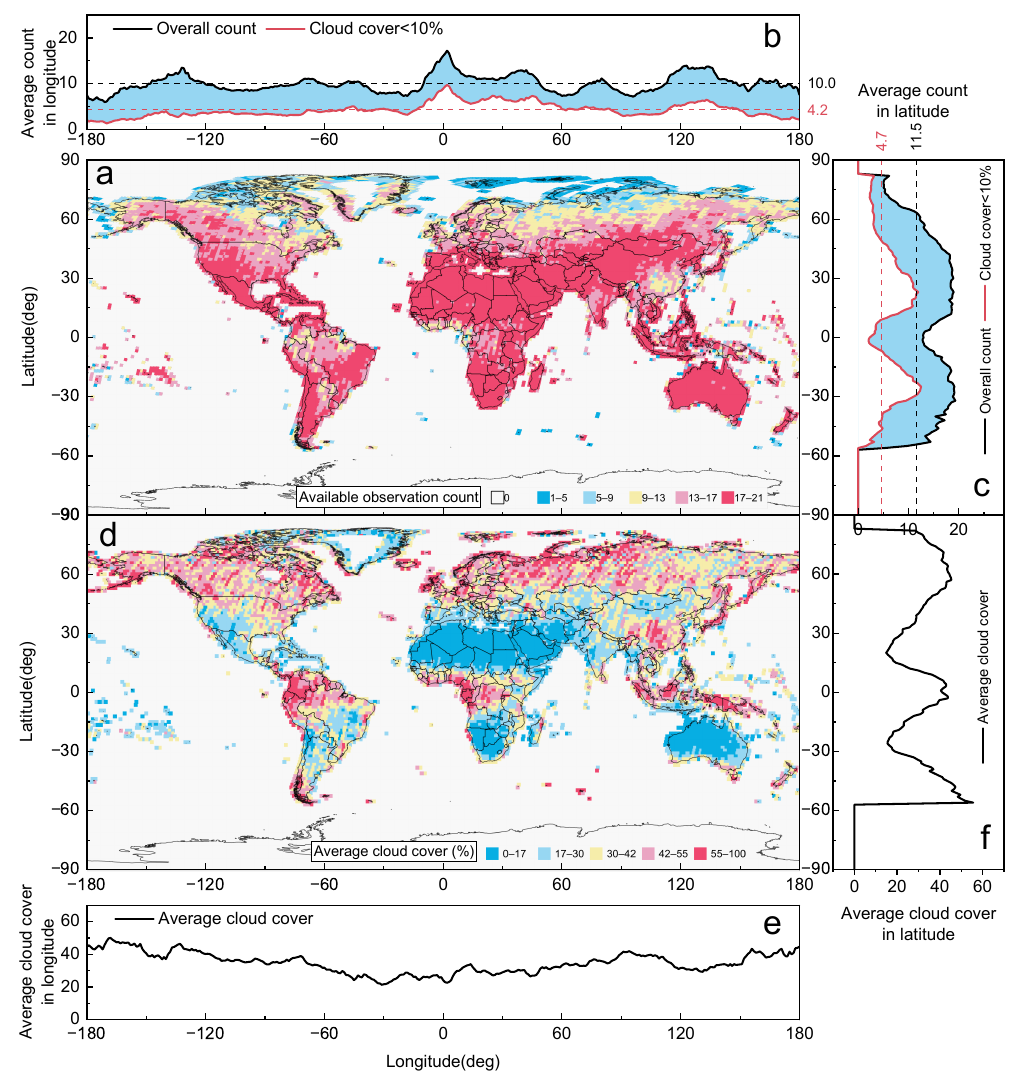
Figure 4. Global spatial distributions of all available Landsat 8 scenes counts and the mean cloud cover in 2019. Among these, ( a ) represents the distribution of the number of available observations count, and ( b,c ) represent the mean available count of the longitude and latitude directions, respectively; ( d ) shows the distribution of cloud coverage, and ( e,f ) represent the average cloud cover of the longitude and latitude directions,